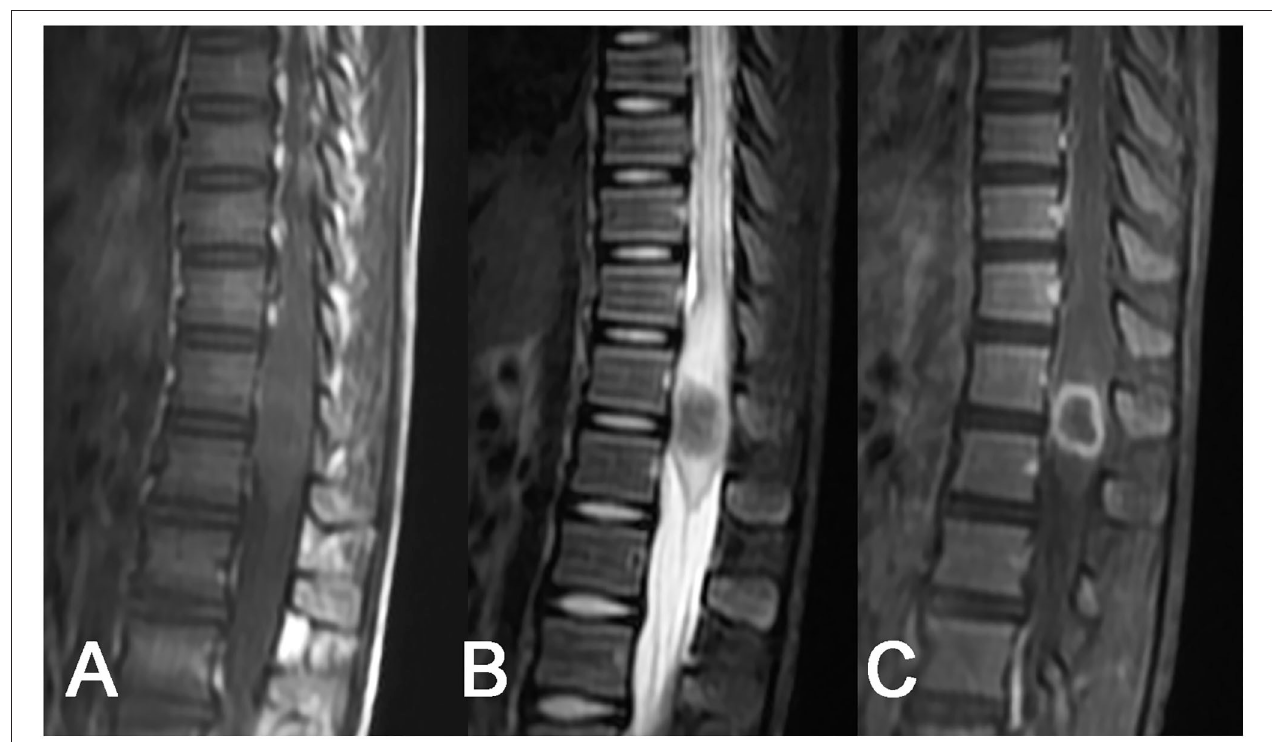
FIGURE 1 | Tuberculoma of the conus medullaris. A slightly enlarged round-like lesion at the conus medullaris: (A) isointense on T1WI, (B) hypointense on T2WI, with poorly defined margins and swelling of the adjacent spinal cord, and (C) homogeneous rim enhancement after contrast